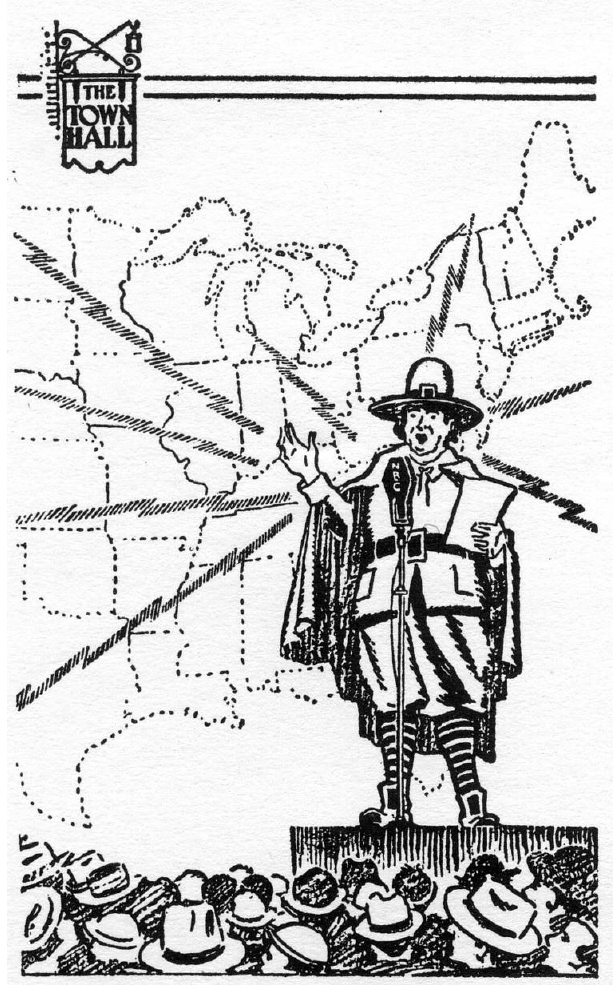
Figure 1: Town Hall, Inc